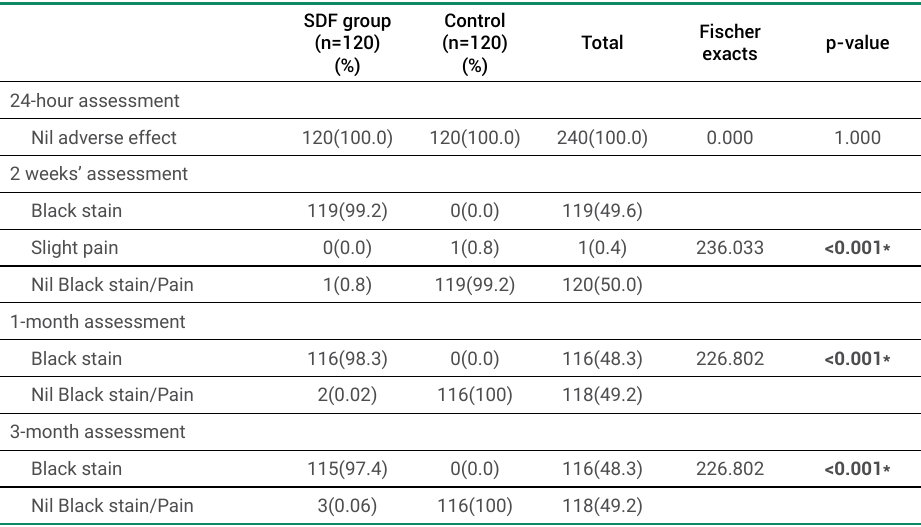
Table 6. Distribution of Adverse effect of intervention at different intervals of